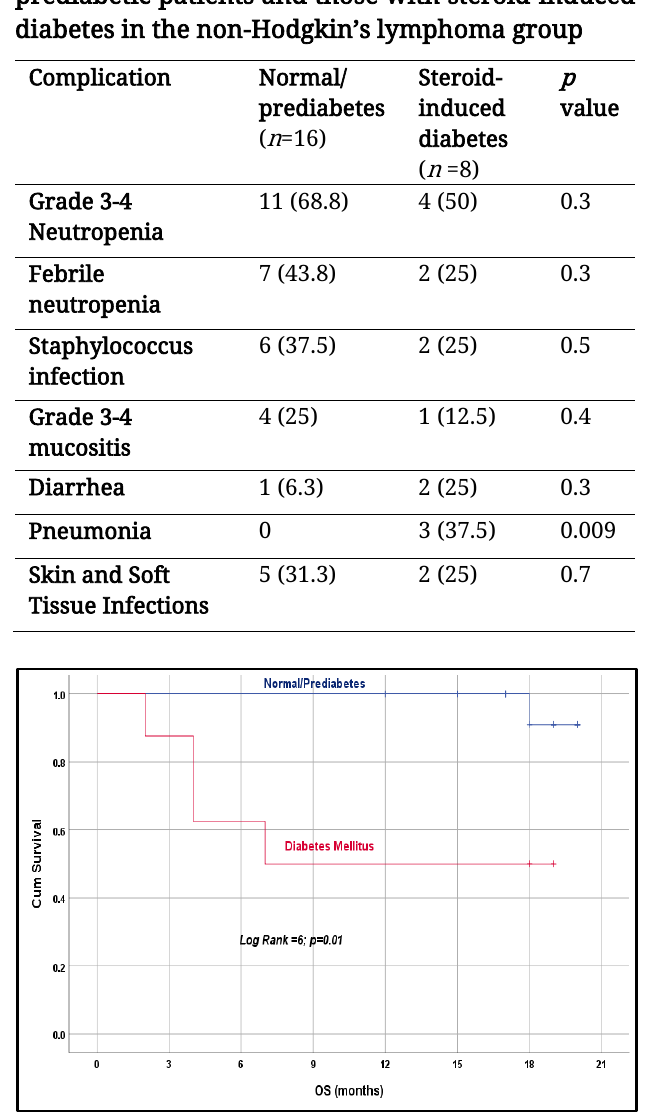
Figure 2: Overall survival curves for normal/ prediabetic patients and those with steroid-induced diabetes in the non- Hodgkin’s lymphoma group emergency room visits. In addition, steroid induced hyperglycemia may have a harmful effect on patient prognosis according to several retrospective studies 5, 8-10 . To the best of our knowledge, this is the first prospective study to assess the prevalence of SID in patients with aggressive lymphoid malignancies during induction therapy and to assess its impact on the treatment